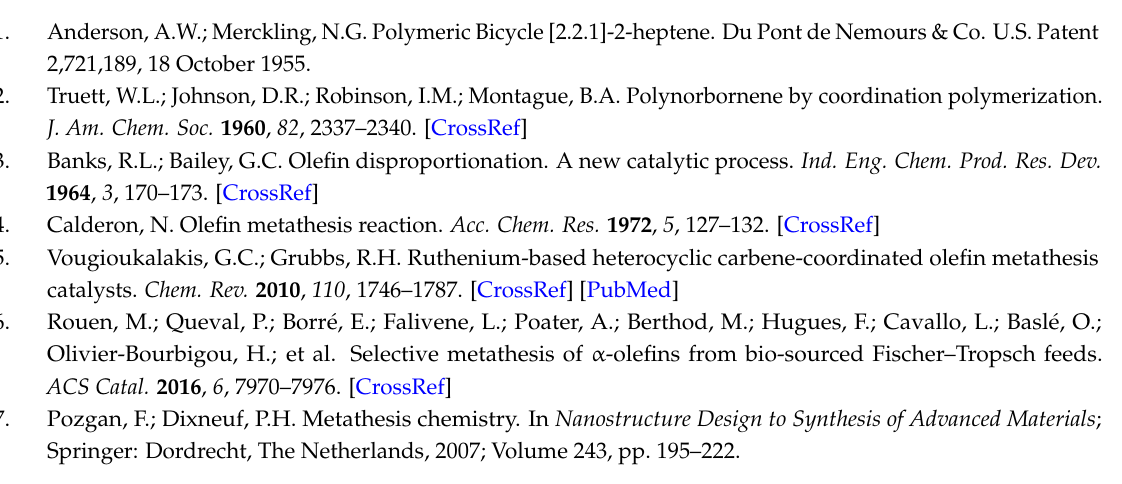
Figure S1: Free-energy profile in solvent for the olefin metathesis reaction of complex A using ethylene as the substrate (energies in kcal/mol calculated at P = 1 atm (instead of 1354); Figure S2: Free-energy profile in solvent for the olefin metathesis reaction of complex B using ethylene as the substrate (energies in kcal/mol calculated at P = 1 atm (instead of 1354), SIMes = 1,3-Bis(2,4,6-trimethylphenyl)-4,5-dihydroimidazol-2-ylidene); Table S1: 3D view and xyz coordinate data sets and absolute energies in a.u. for DFT optimized complexes. Acknowledgments: The Centre National de la Recherche Scientifique (CNRS) is acknowledged for half